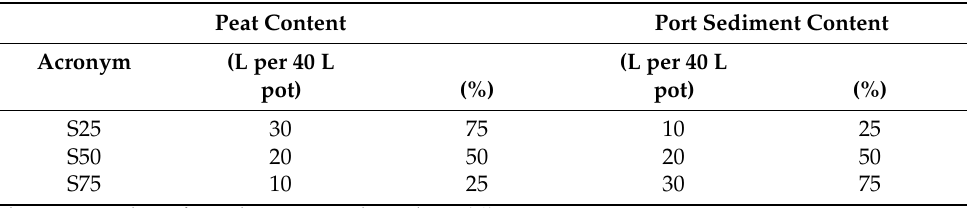
Table 1. Port sediment and peat, mixed in the culture media used in this study. The values represent the substrate